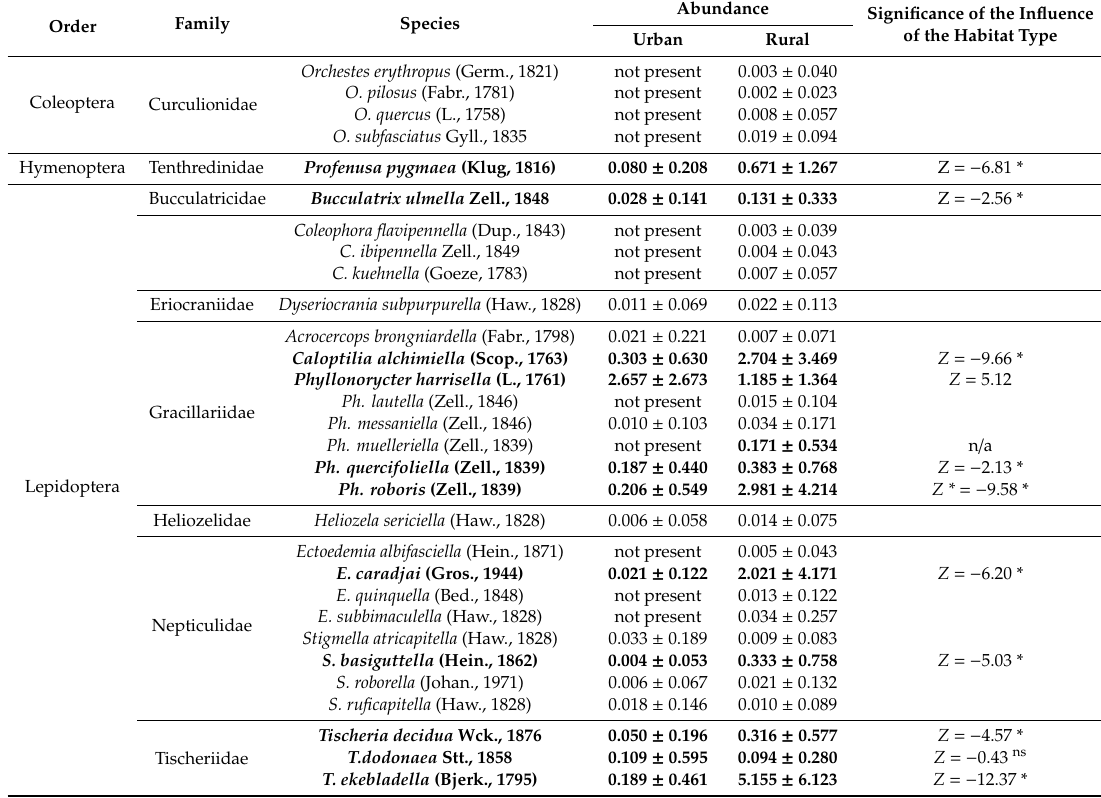
Table 1. Identified species of leaf miners, their average abundance (number of mines per 100 leaves ± s.d.) on trees in the urban and rural environments, and e ff ect of habitat type on the frequent species (present in > 20% samples) assessed by Z